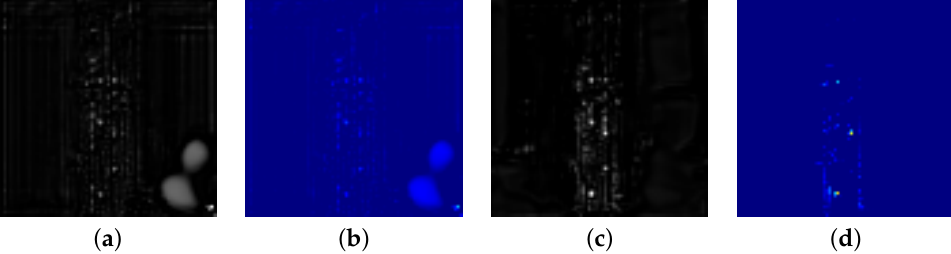
Figure 10. Activation ( a ) and related CAM ( b ) were generated with a model with normal convolutions, whereas for the exact same sample activation ( c ) and related CAM ( d ) were obtained with a model with Sparsity Invariant Convolutions instead. We can observe the noise in the former activation map, which also corrupts generated CAM. The latter example shows that the sparsity invariant operation surpasses the previous method, especially when it comes to empty input cells. As a result, the generated CAM is concentrated on actual detections with a higher